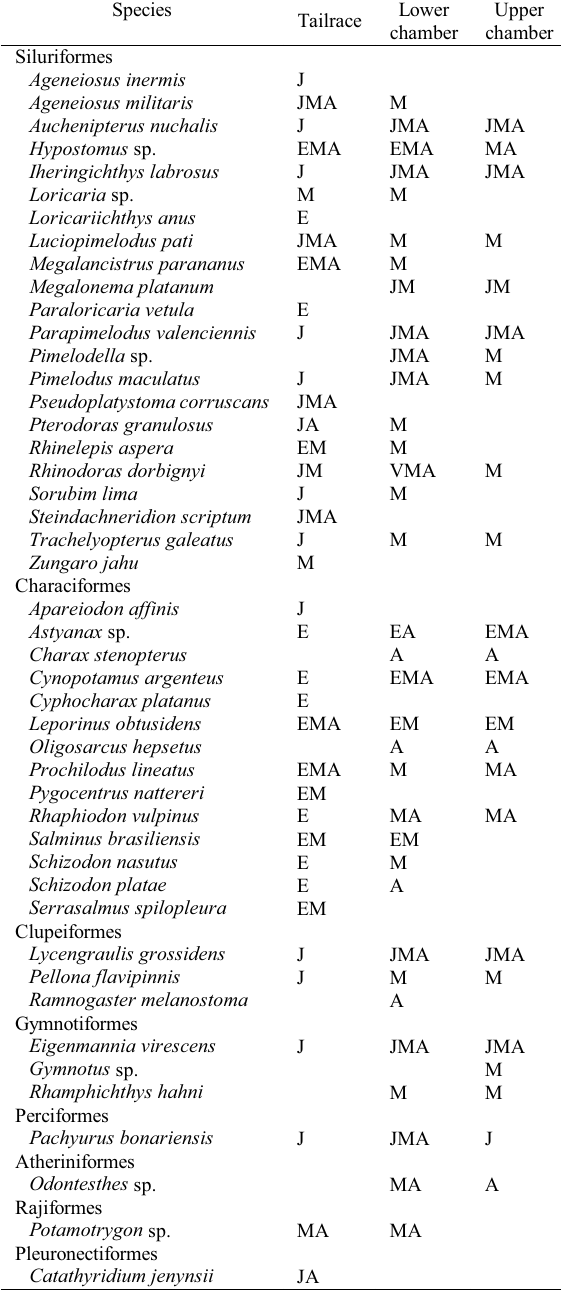
Table 2. Recorded species at the tailrace, lower chamber and upper chamber in Borland locks. J: January, 1993; M: